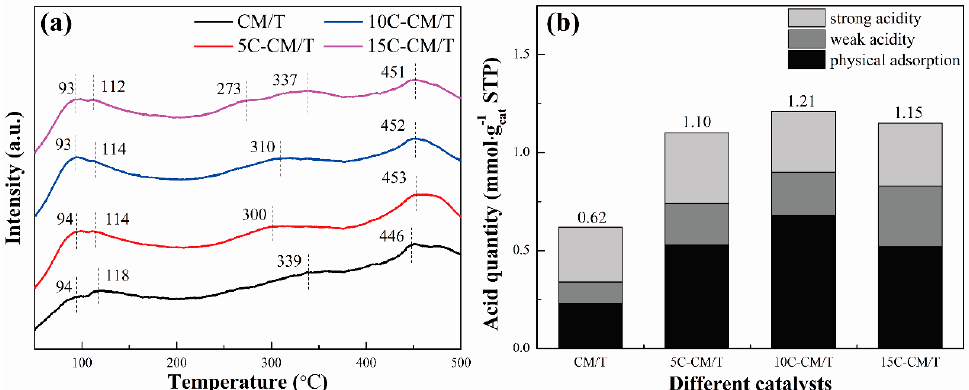
Table 1. Pore structures of the obtained catalysts.